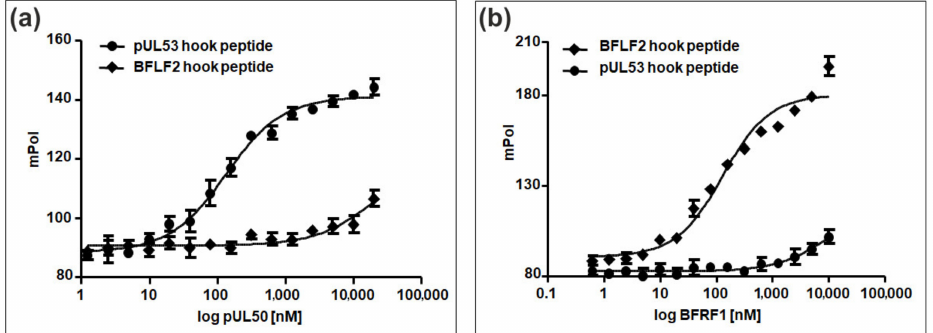
Figure 5. HCMV- / EBV-specific core NEC interaction properties measured in a hook-into-groove binding assay. ( a ) Binding to HCMV pUL50: the pUL53 hook peptide (see Table S1 for peptide sequences), but not the BFLF2 hook peptide, is able to interact with the HCMV groove protein pUL50. ( b ) Binding to EBV BRFR1: likewise, the BFLF2 hook peptide, but not the pUL53 hook peptide, is able to interact with the EBV groove protein BFRF1. All interactions were measured by the fluorescence polarization assay using fluorescein-labeled synthetic hook peptides in conjunction with recombinant groove proteins produced in E. coli